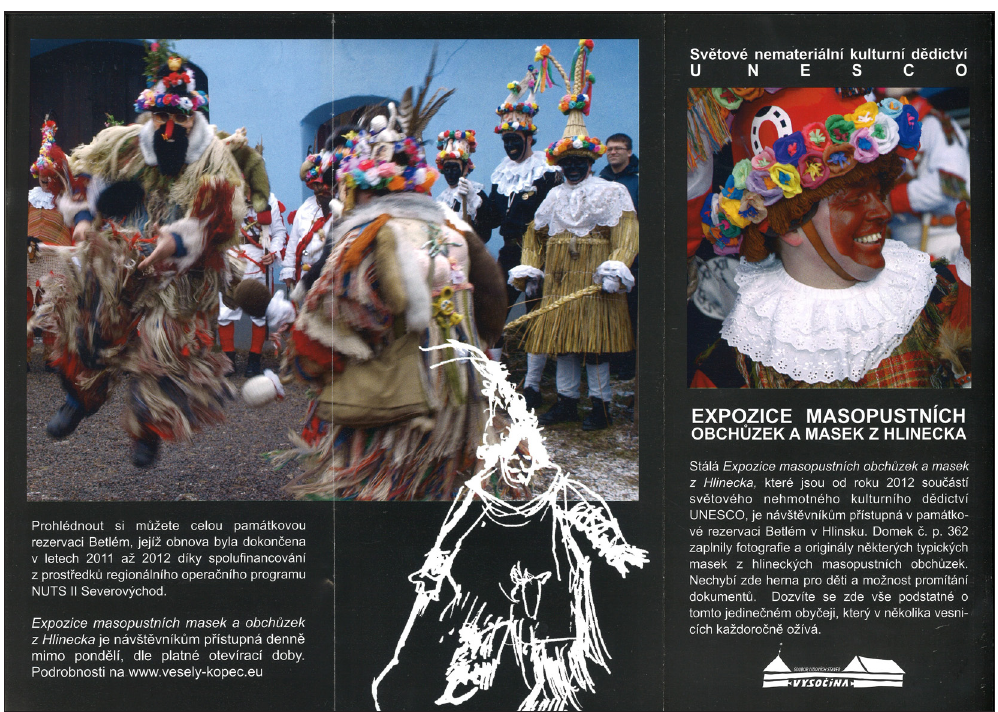
Figure 2: A leaflet about Masopust in Hlinsko published after the Unesco recognition. (Collected in Hlinsko in